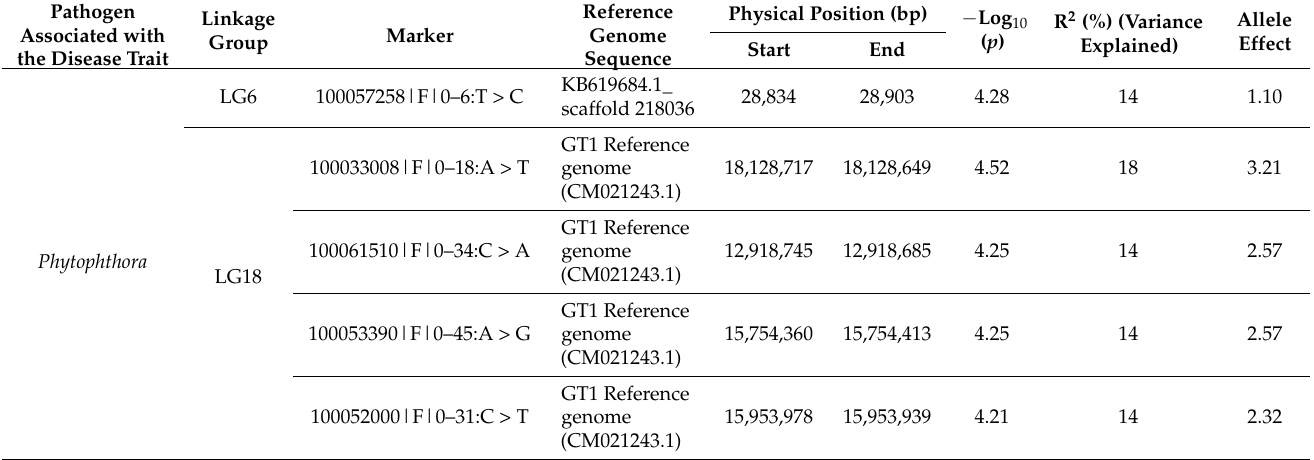
Table 2. Markers that showed significant associations with disease traits in the integrated map of Hevea brasiliensis and H. benthamiana